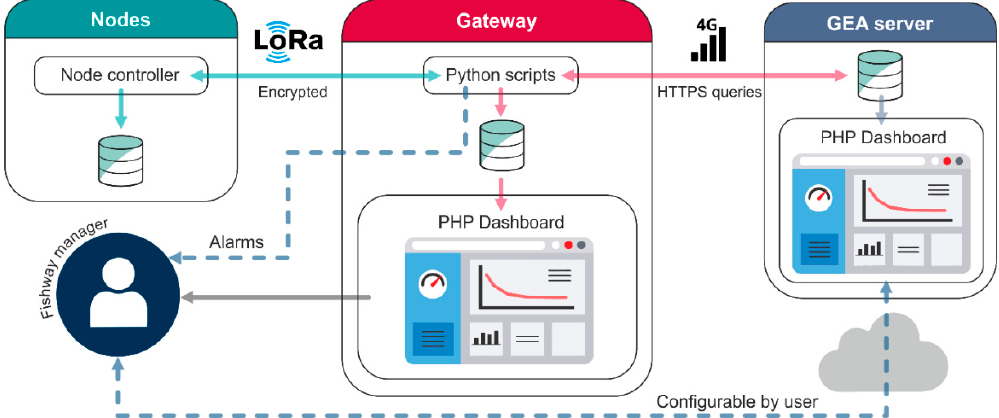
Figure 3. The general architecture of the sensor network.